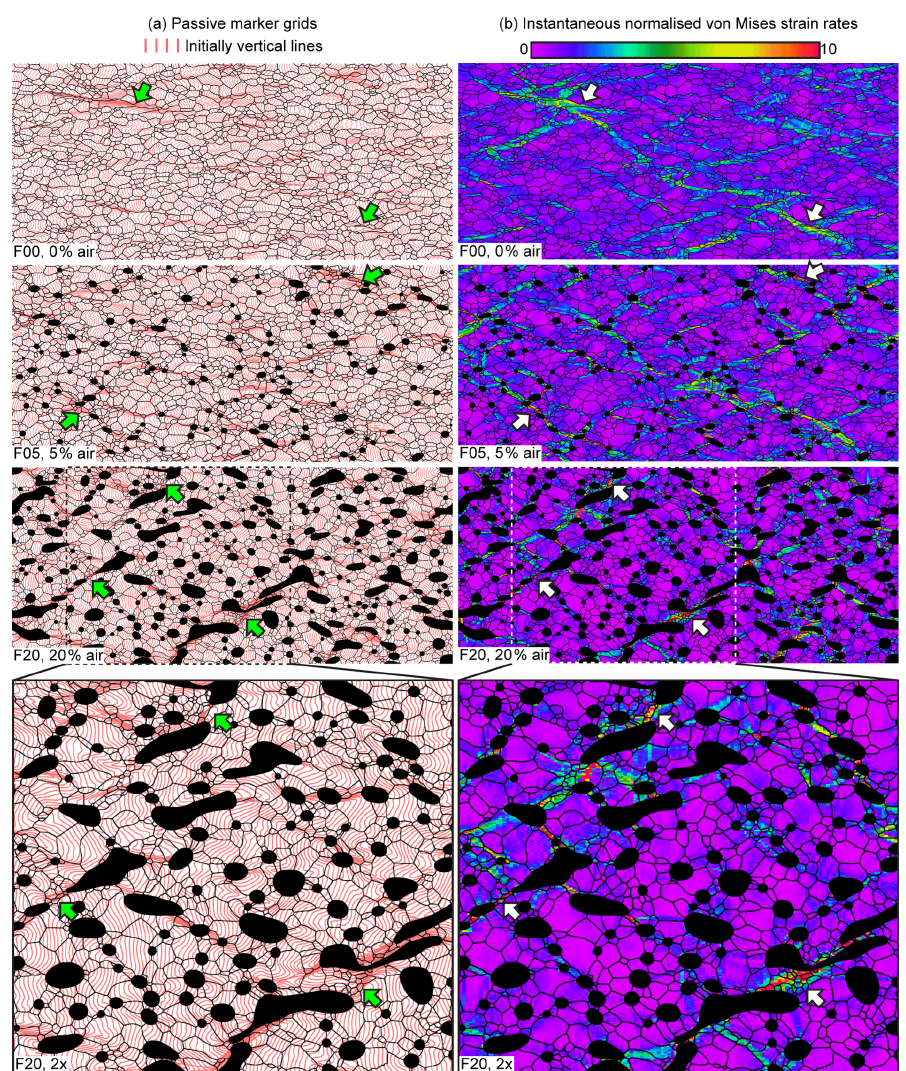
Figure 3. Overview of modelling results at last time step at 53% vertical shortening under pure shear conditions. (a) Grain-boundary network superimposed on passive marker grid of initially vertical parallel lines to show the finite strain distribution. (b) The same microstructures superimposed on the map of instantaneous strain rates expressed as von Mises strain rates normalized to the bulk value. Arrows in both images indicate zones of marked strain localization. Air inclusions are displayed in